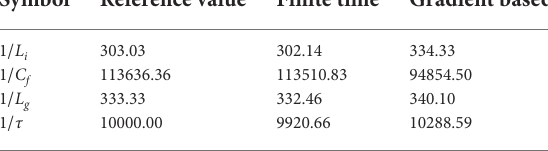
TABLE 2 Estimation of